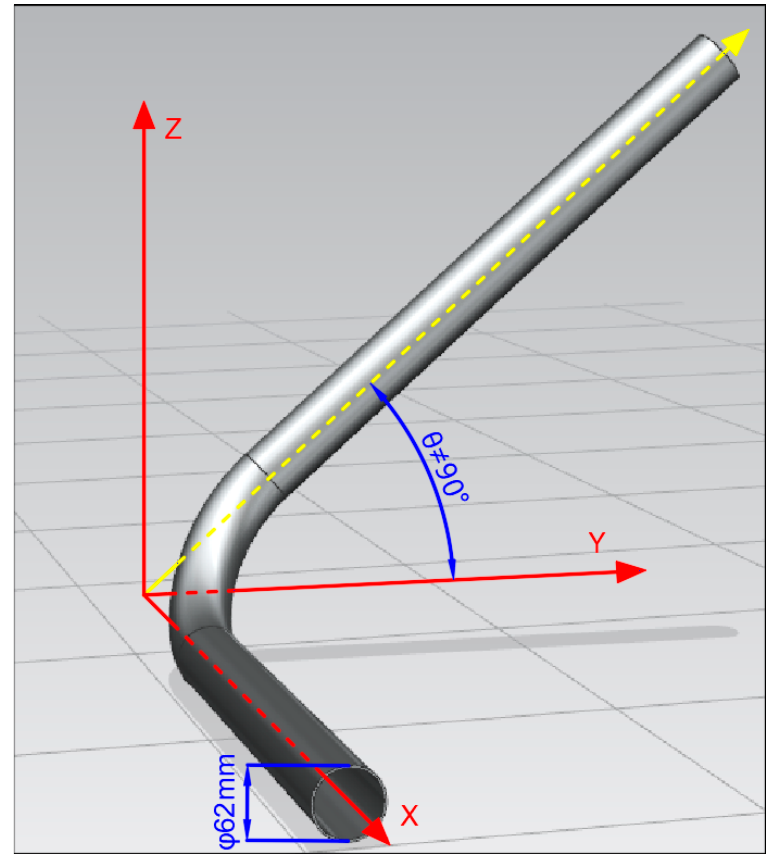
Figure 2. Atypical ‐ bend diagram. Figure 2. Atypical-bend